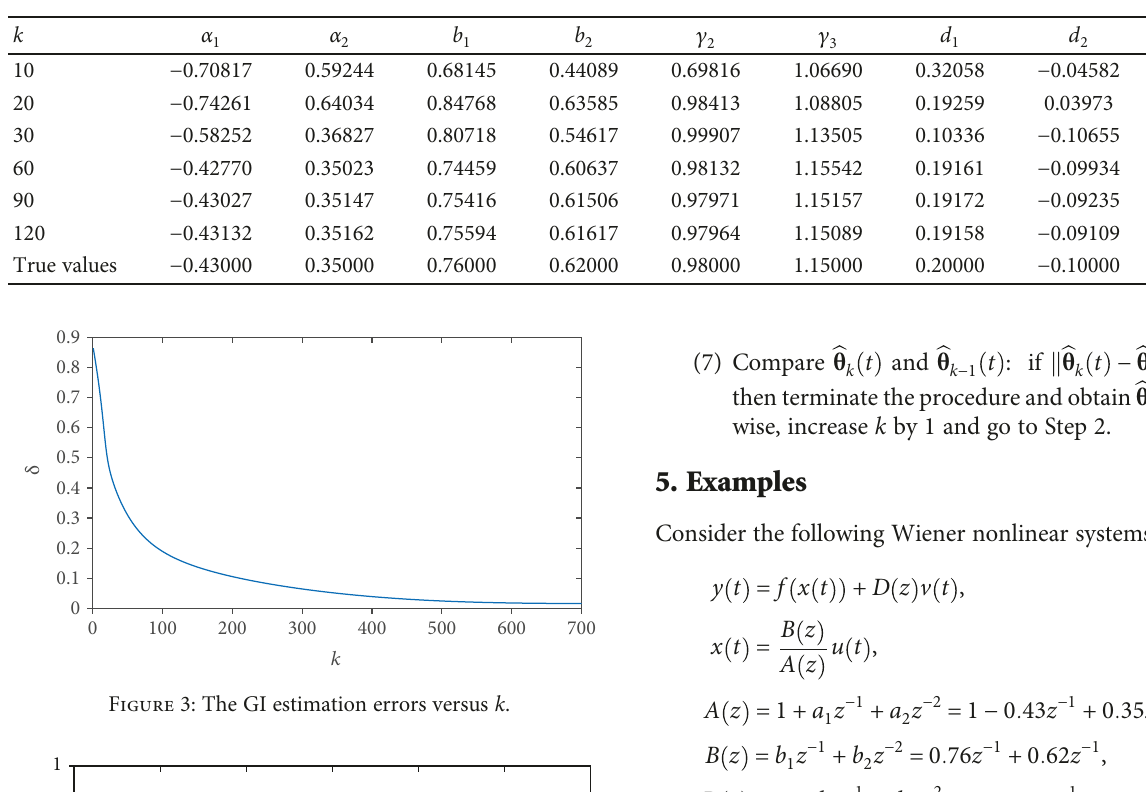
Table 2: The PSOI estimates and errors ( M = 60 ).